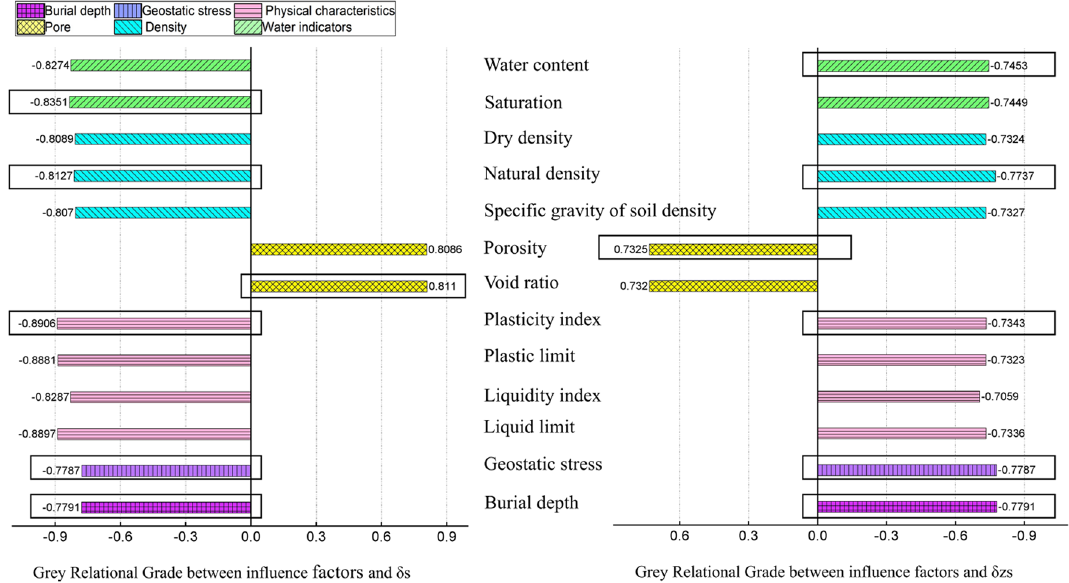
Figure 5. Grey relational grades between influence factors and δs or